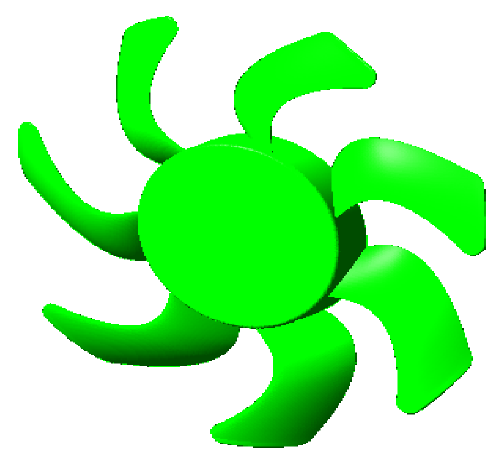
Figure 7. Fan 3D model. Figure 7. Fan 3D